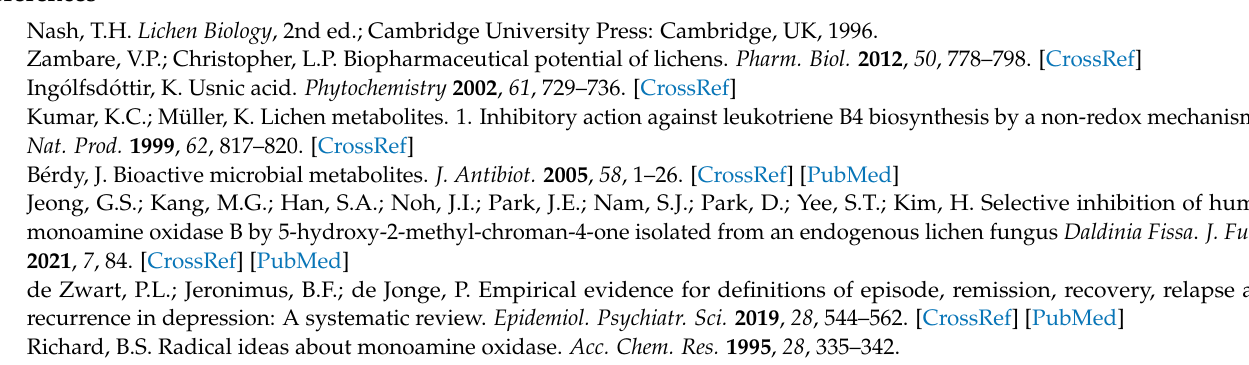
(2); Figure S3. Percentage purity of MED (3); Figure S4. 1H NMR spectrum of alternariol (AT) (1) in CD3OD; Figure S5. 13C NMR Spectrum of alternariol (AT) (1) in CD3OD; Figure S6. COSY Spectrum of alternariol (AT) (1) in CD3OD; Figure S7. HSQC Spectrum of alternariol (AT) (1) in CD3OD; Figure S8. HMBC Spectrum of alternariol (AT) (1) in CD3OD; Figure S9. 1H NMR spectrum of 5 (cid:48) -hydroxy- alternariol (HAT) (2) in DMSO-d6; Figure S10. 13C NMR Spectrum of 5 (cid:48) -hydroxy-alternariol (HAT) (2) in DMSO-d6; Figure S11. COSY Spectrum of 5 (cid:48) -hydroxy-alternariol (HAT) (2) in DMSO-d6; Figure S12. HSQC Spectrum of 5 (cid:48) -hydroxy-alternariol (HAT) (2) in DMSO-d6; Figure S13. HMBC Spectrum of 5 (cid:48) -hydroxy-alternariol (HAT) (2) in DMSO-d6; Figure S14. 1H NMR Spectrum of mycoepoxydiene (MED) (3) in DMSO-d6; Figure S15. 13C NMR Spectrum of mycoepoxydiene (MED) (3) in DMSO-d6; Figure S16. COSY Spectrum of mycoepoxydiene (MED) (3) in DMSO-d6; Figure S17. HSQC Spectrum of mycoepoxydiene (MED) (3) in DMSO-d6; Figure S18. HMBC Spectrum of mycoepoxydiene (MED) (3) in DMSO-d6; Figure S19. Plots of root mean square deviation (RMSD) during 1 ns MD simulation of the complex with (a) hMAO-A and AT, and (b) hMAO-B and